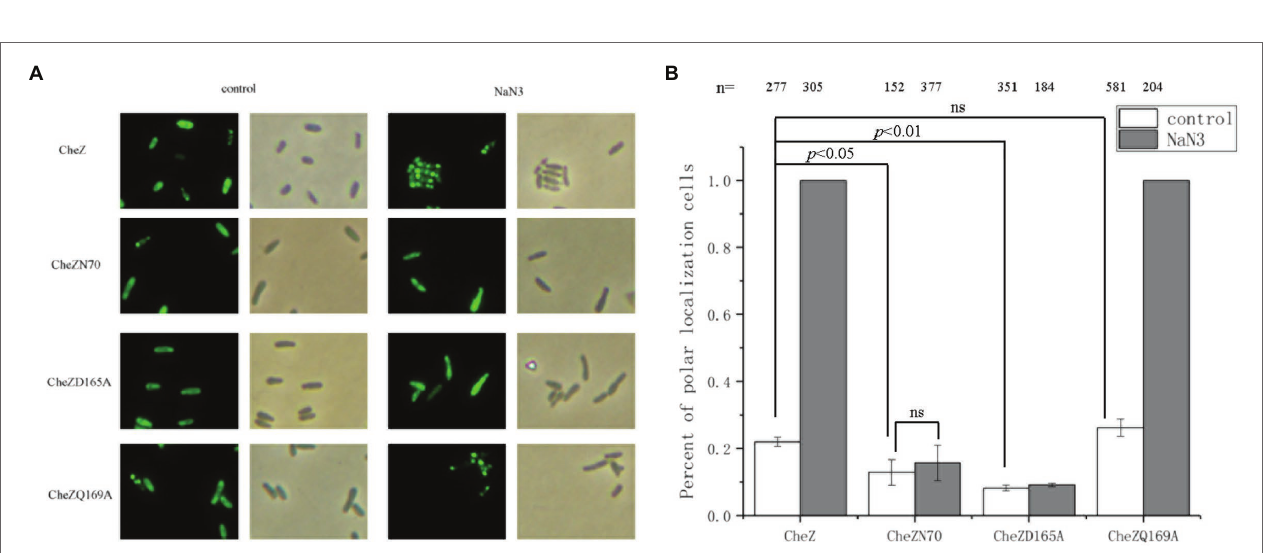
FIGURE 3 | Localization of CheZ with electron transport chain inhibitors. (A) Representative images of CheZ localization in cells incubated with electron transport chain inhibitors sodium azide or CCCP, and with shaking for 12 h. Cell cultures without inhibitor were used as control. (B) Quantification of cell ratios with polar localization of CheZ. Data are shown as means ± SDs from three independent experiments.